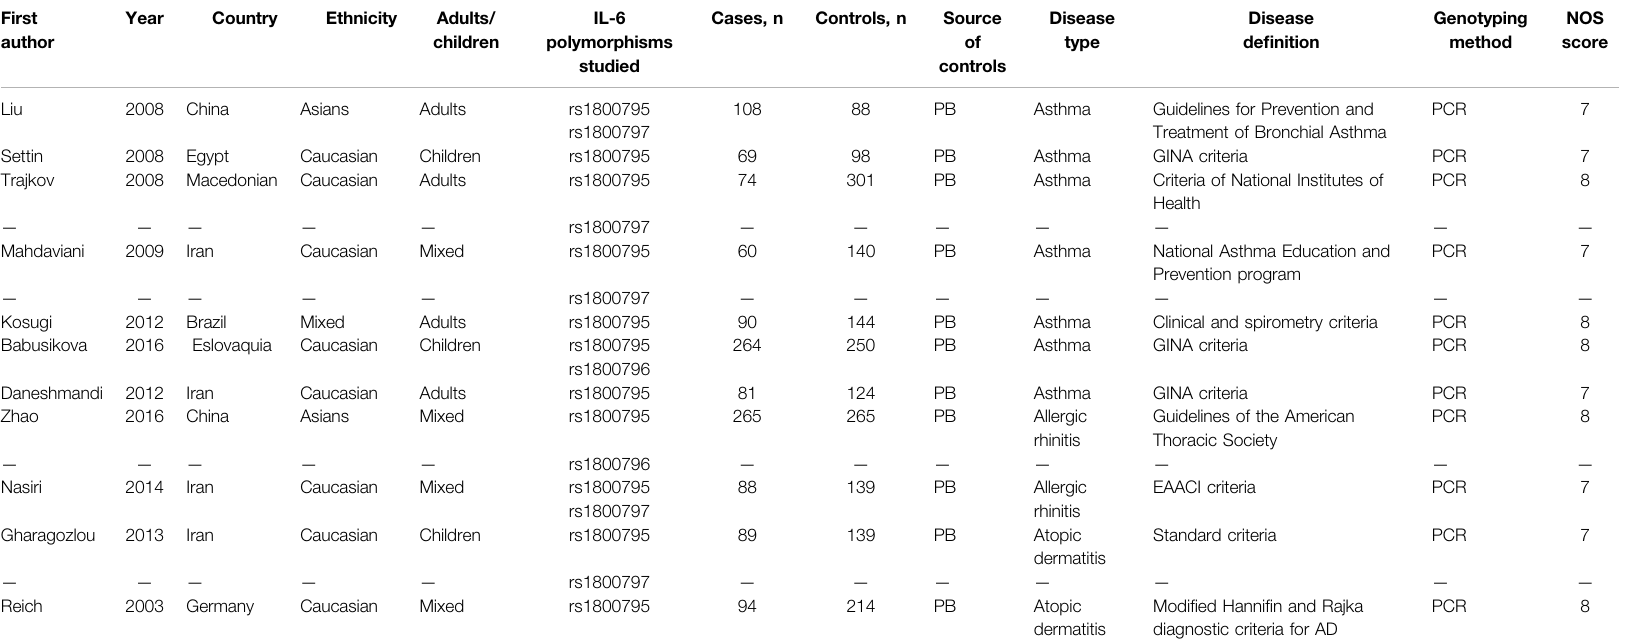
TABLE 1 | Characteristics of the 11 case – control studies included in the